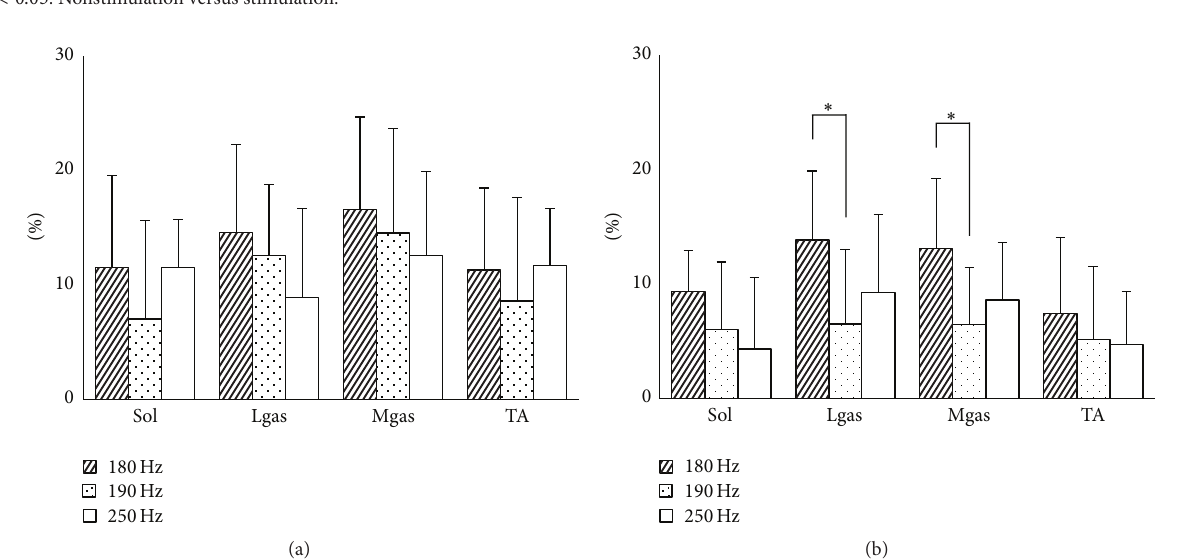
Figure 2: The increase rate of muscle force by the vibration frequency applied on the Achilles tendon and tibialis anterior tendon [%] ( ∗ 𝑝 < 0.05 . 180 Hz versus 190 Hz). (a) Achilles tendon. (b) Tibialis anterior tendon.